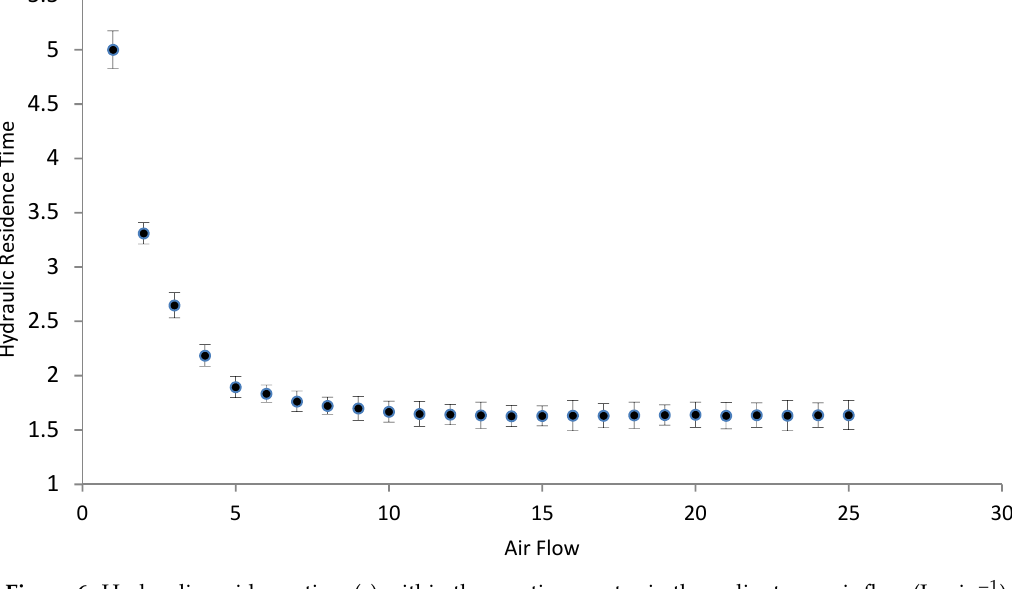
Figure 6. Hydraulic residence time (s) within the aeration reactor in the ordinate vs. air flow (L min − 1 ) in the abscissa.